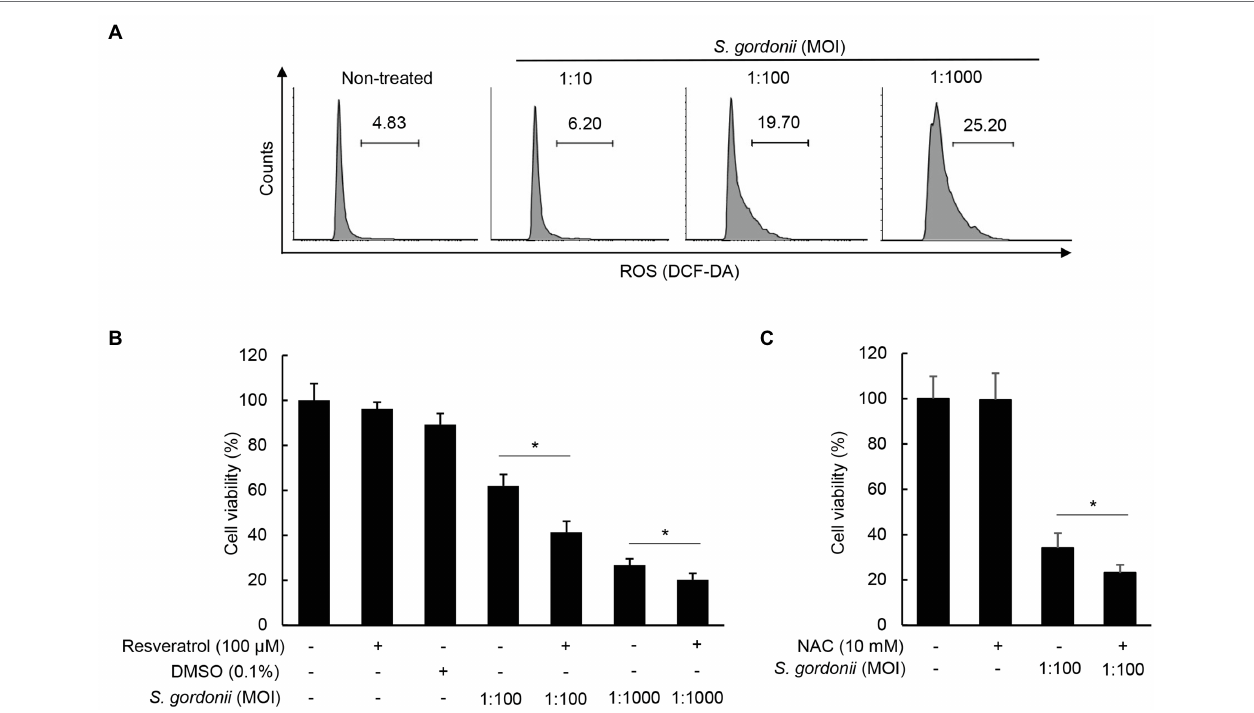
FIGURE 3 | S. gordonii induces reactive oxygen species (ROS) production regardless of its cytotoxic effects in PDL cells. (A) PDL cells were treated with 10 μ M of DCF-DA for 30 min at 37 ° C. After washing with PBS, the DCF-DA-labeled cells were treated with S. gordonii at MOI 1:10, 1:100, or 1:1,000 for 3 h. Fluorescent intensity was analyzed by flow cytometry. (B) PDL cells were pre-treated with 100 μ M of resveratrol for 1 h, followed by treatment with S. gordonii at MOI 1:100 or 1:1,000 for 3 h. (C) PDL cells were pre-treated with 10 mM NAC for 1 h, followed by treatment with S. gordonii at MOI 1:100 for 3 h. Trypan blue assay was used to determine the number of viable cells. One of three similar results is shown. * p <